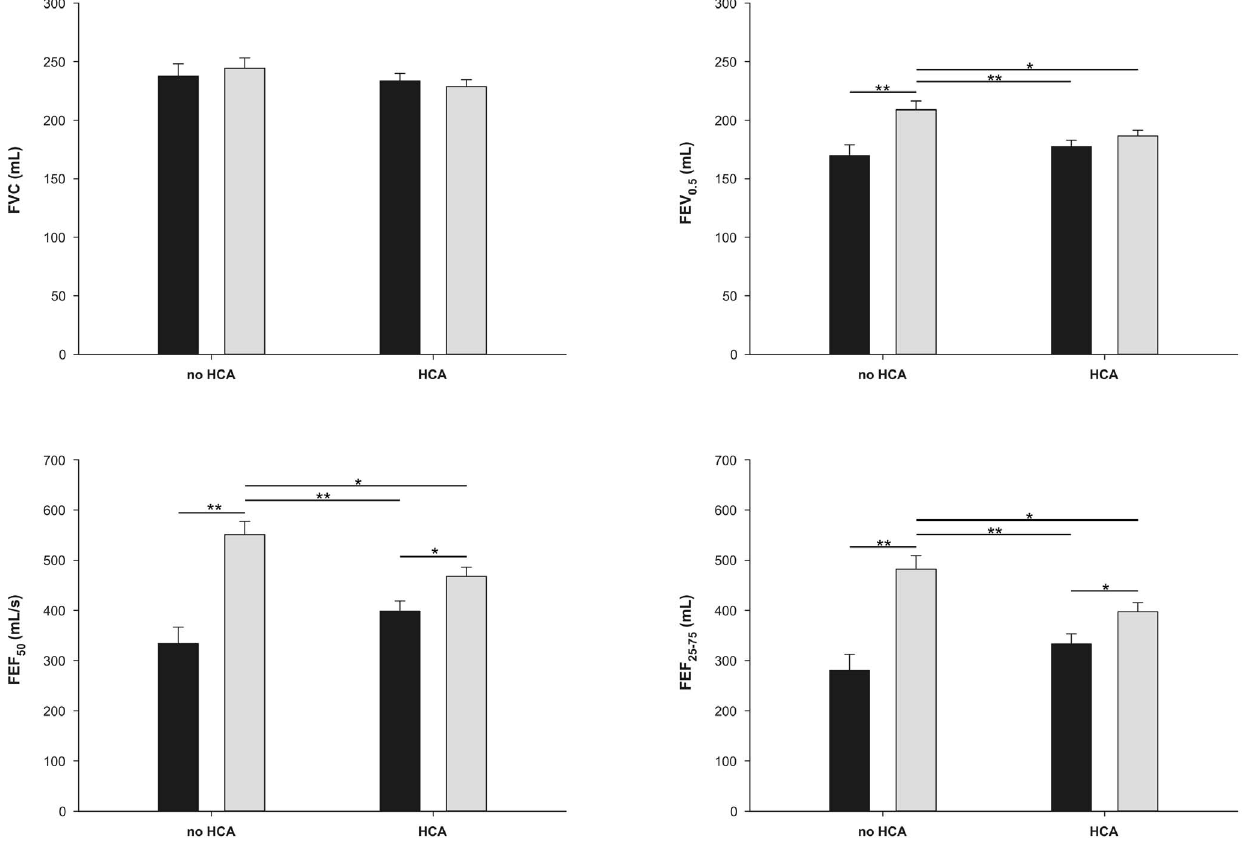
Figure 2. Lung function adjusted for body length and gestational age in male (black) and female (gray) premature infants. Data are represented as the mean ( + SD). Sixty-six (35 female) were exposed to HCA (combined Grade 1 and Grade 2) and 29 not exposed to HCA (17 female). There was a significant sex by HCA interaction for FEF 50 (F=8.76; p=0.004), FEF 25–75 (F=8.11; p=0.005) and FEV 0.5 (F=4.81; p=0.031). Post hoc analyses revealed a significant reduction in lung function in exposed female preterm infants when compared to females not exposed to HCA. The effect of exposure to HCA was not significant in males. * p , 0.05, ** p , 0.01 (Post hoc Holm-Sidak test). doi:10.1371/journal.pone.0081193.g002 PLOS ONE |